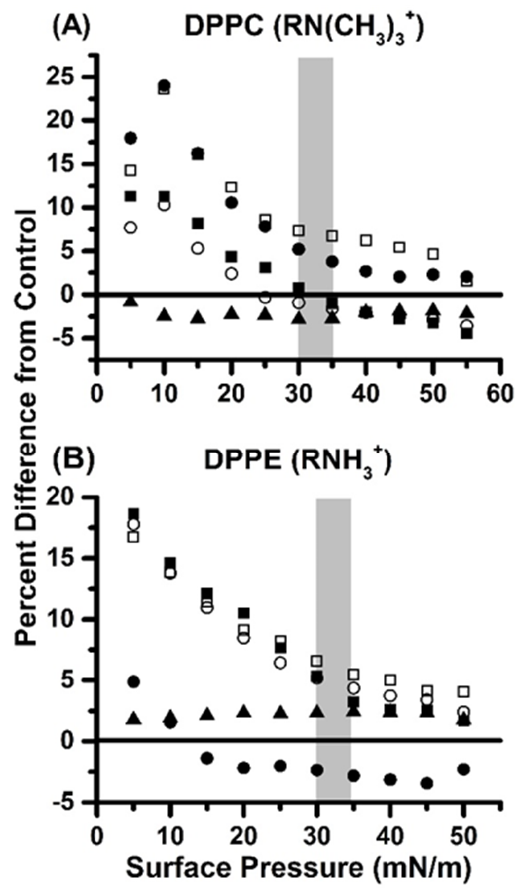
Figure 6. Calculated percent difference between the area per molecule of control Langmuir monolayers and monolayers with glycine in the subphase for ( A ) dipalmitoyl phosphatidylcholine (DPPC) and ( B ) dipalmitoyl ethanolamine (DPPE). R represents the phosphate group, glycerol, and saturated C 16 tails. Symbols each represent a different pH, where solid squares are pH 4, hollow squares are pH 6, solid circles are pH 7, hollow circles are pH 8, and solid triangles are pH 9. The region shaded in grey represents physiological surface pressure. Exact values and errors for all points are reported in Tables S1 and S2.